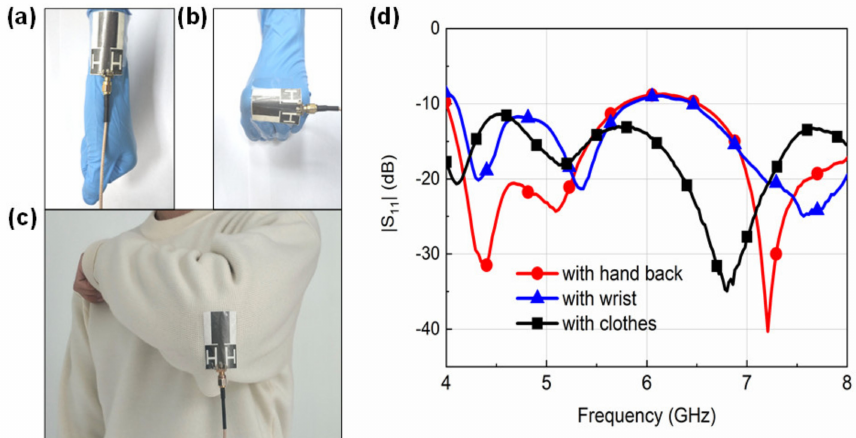
Figure 4. ( a – c ) Antennas under di ff erent application scenarios: ( a ) attached to the wrist, ( b ) attached to the back of the hand, ( c ) clipped onto clothes. ( d ) | S 11 | curves of the GAF antenna when attached to the back of the hand (red), wrist (blue), and clothes